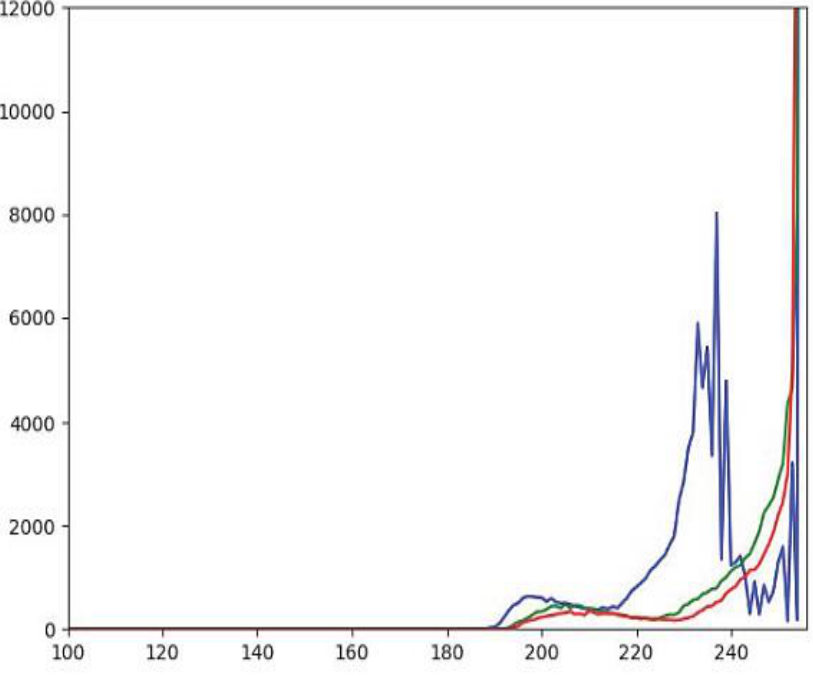
Figure 20. Histogram of the RGB graph for the image (see Figure